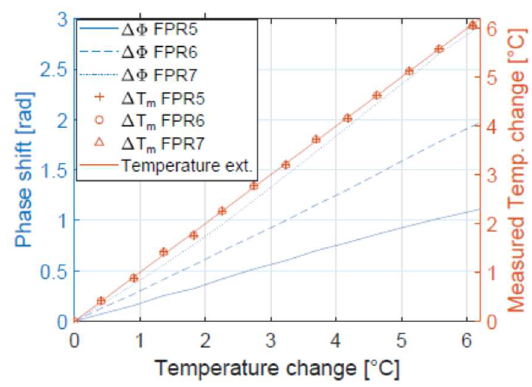
Fig. 5. Response of the solid fiber sections for an induced change in temperature.